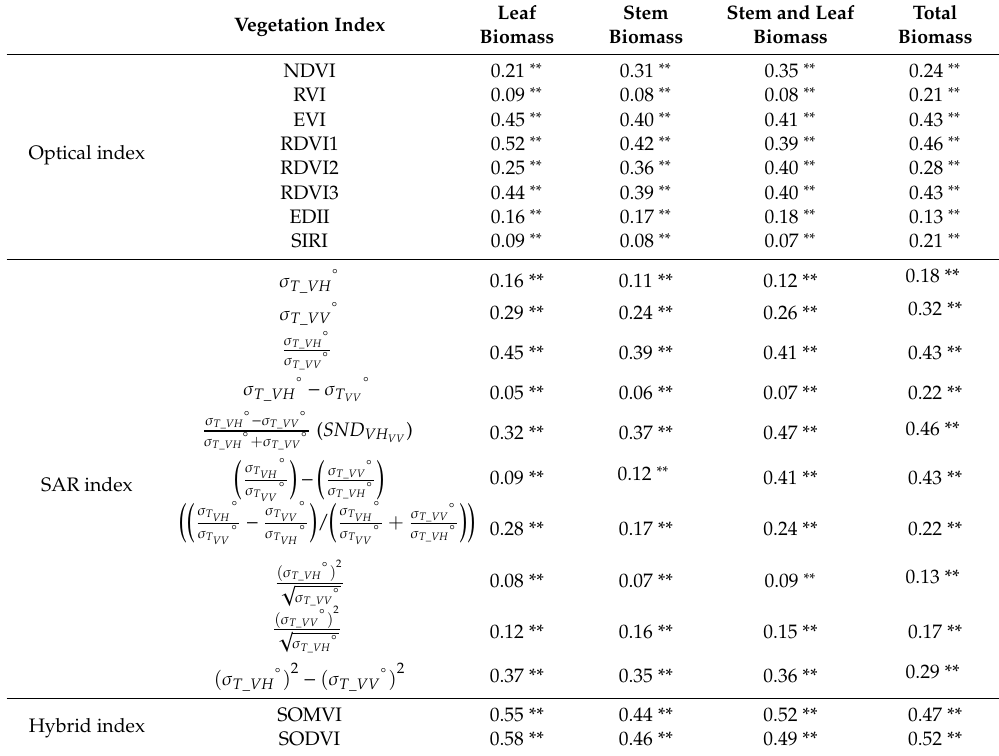
Table 3. Comparison of squared correlation coe ffi cients for the relationship between each vegetation index and biomass